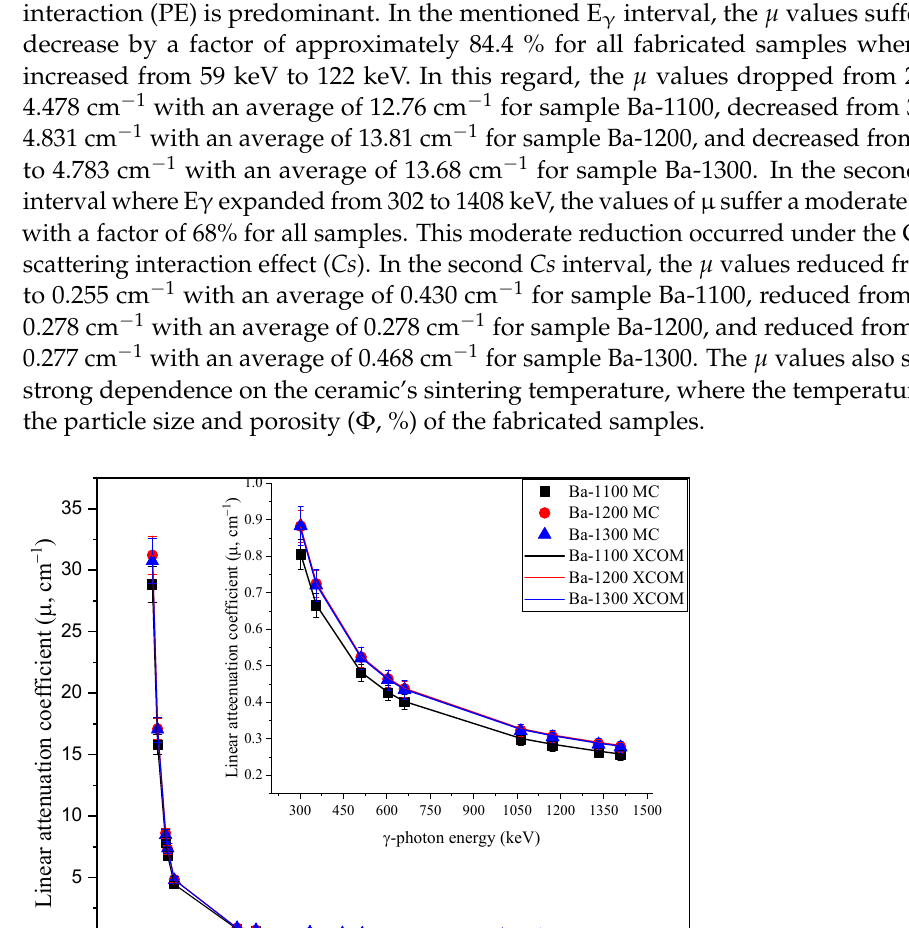
Figure 6. Dependence of the μ values on the porosity of the samples ( Φ , %).